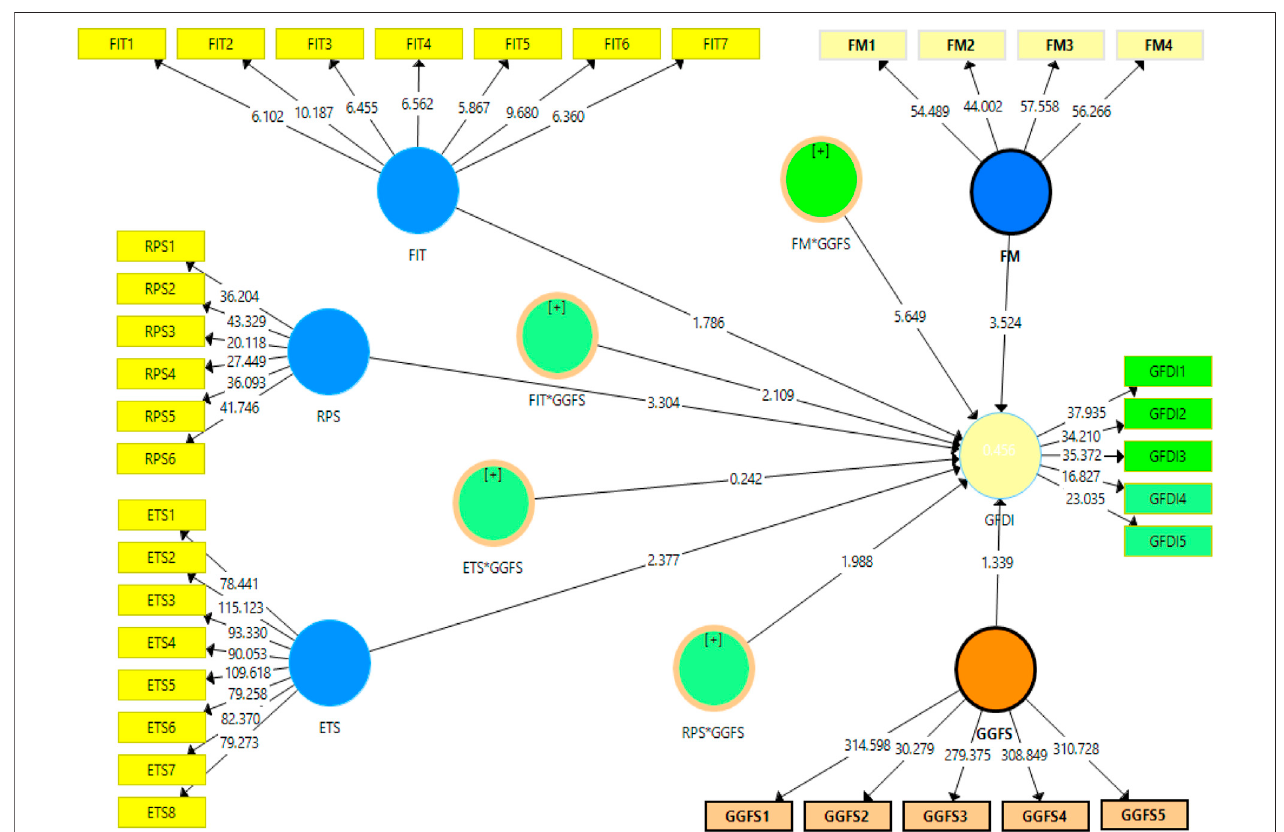
FIGURE 3 | Structural assessment